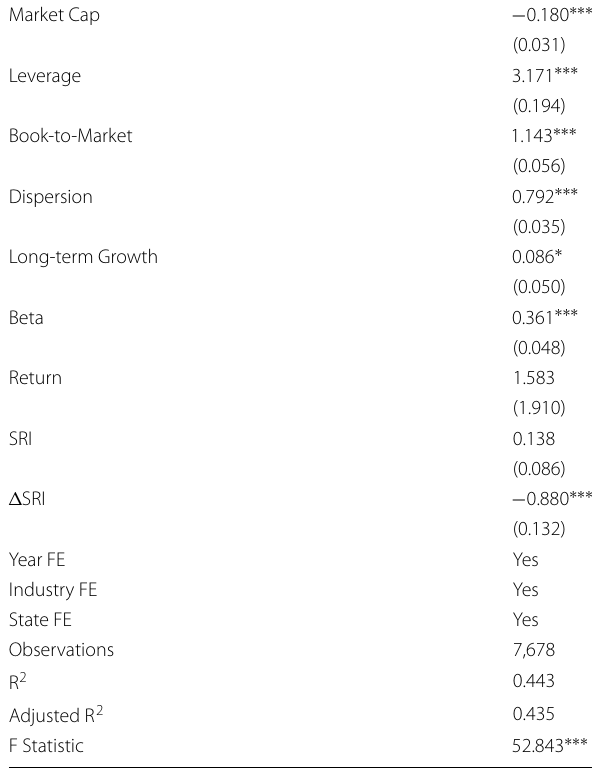
Table 9 Results of difference-in-differences